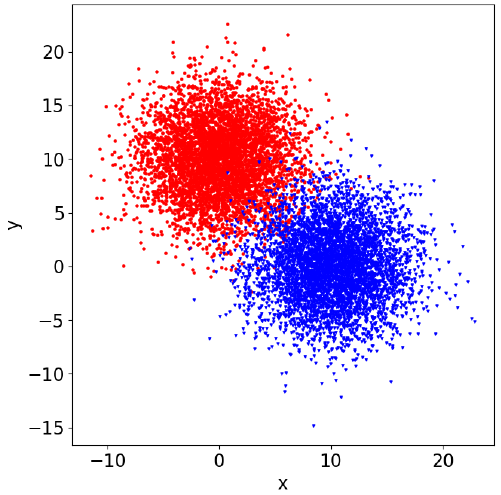
Figure 1. Visualization of the Gaussian points belong to two different distributions. The blue points show X 1 ∼ N ( µ 1 , σ 1 ) , and the red points represent X 2 ∼ N ( µ 2 , σ 2 )